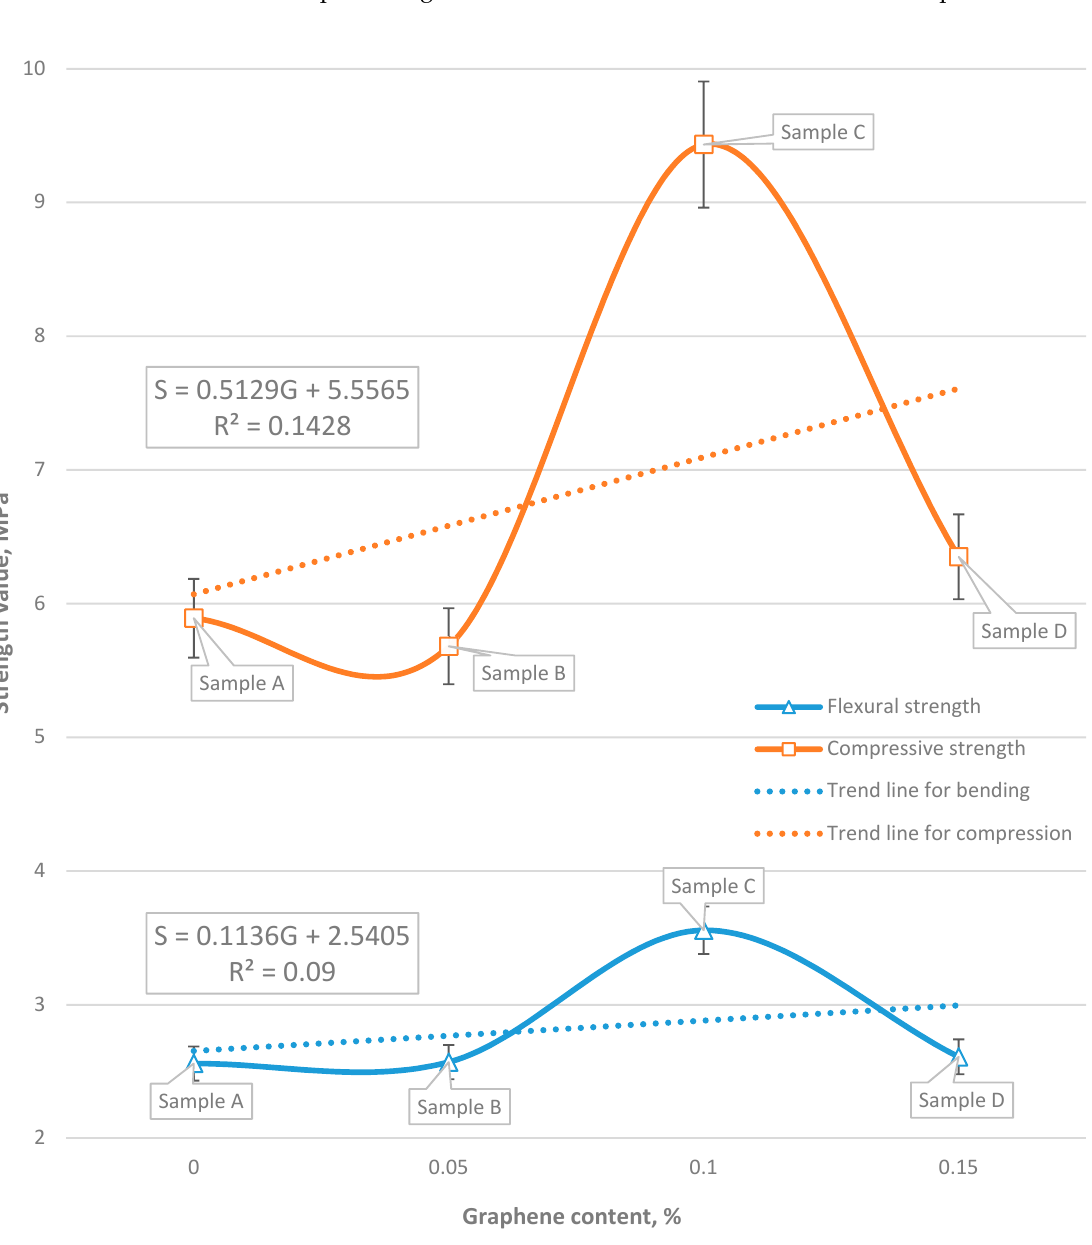
Figure 12. The relationship between the strength of cement samples (S) and the graphene percentage (G).